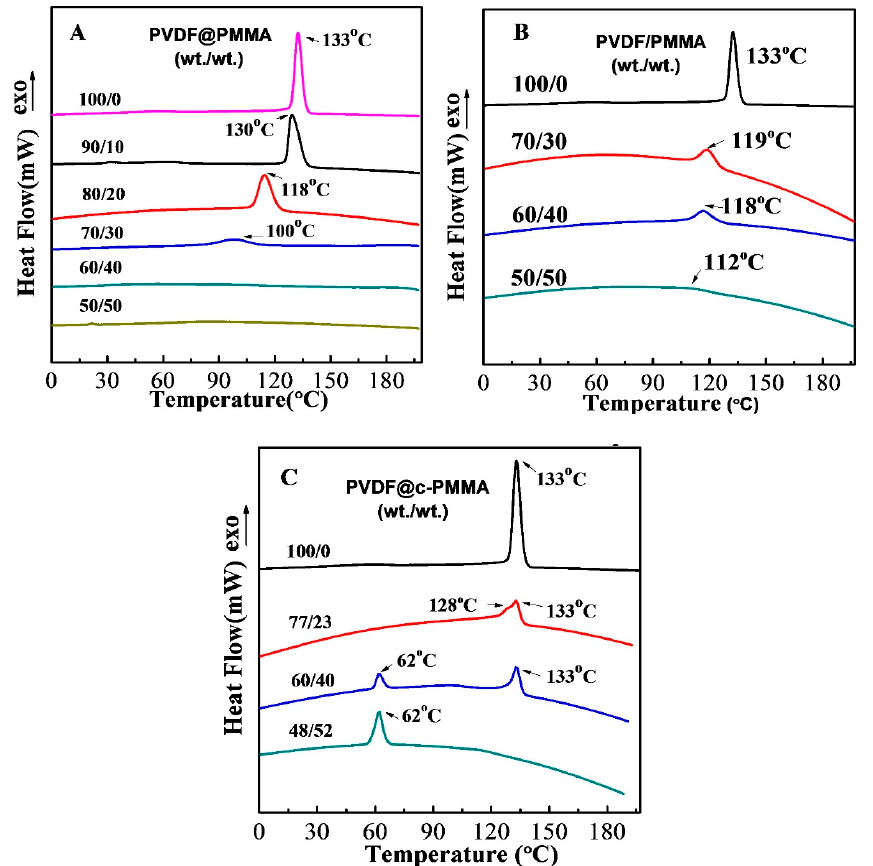
Figure 2. DSC cooling curves showing the crystallization traces of three series of the samples: ( A ) PVDF@PMMA; ( B ) PVDF/PMMA; and ( C ) PVDF@c–PMMA, at various weight ratios of PVDF to PMMA. The cooling rate was − 10 °C/min.